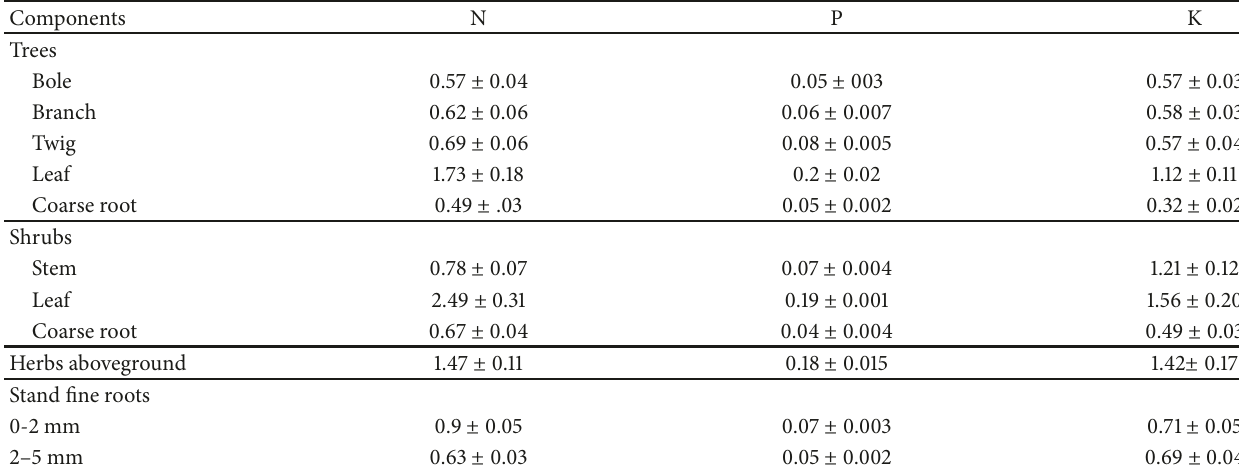
Table 2: Nutrient concentrations (%) (mean ± SE) in tree, shrub, herb, and fine root of moist tropical forest in Sunsari district, eastern Nepal. Components N